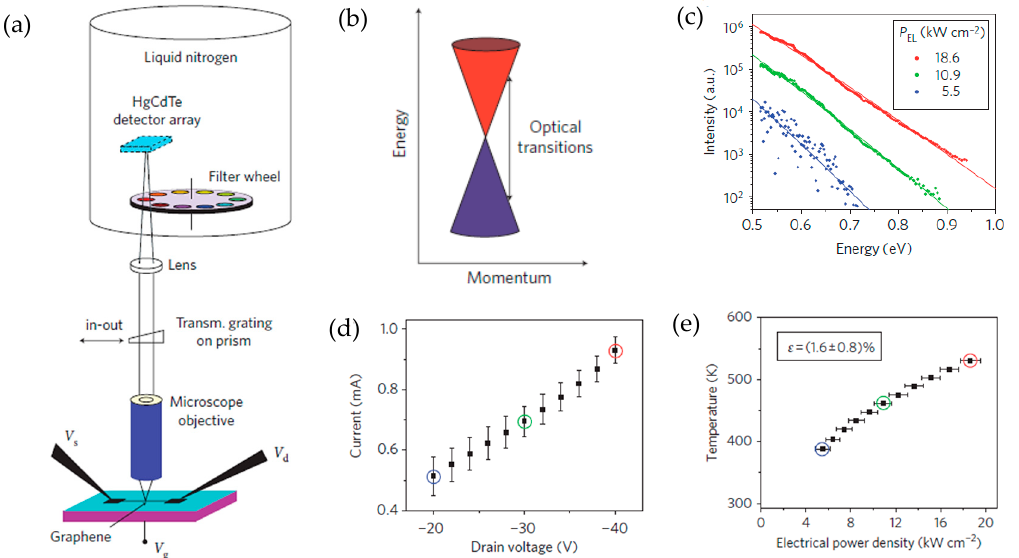
Figure 1. ( a ) Shows the experiment setup comprised of infrared imaging, vacuum prob station, and microscope with sensitivity between 0.95 and 0.5 eV. In this, the grating transmission was utilized for spectroscopy and then detached for infrared imaging; to cut down the dark count, a low pass filter was utilized. ( b ) The direct point vicinity related to the electron dispersion. ( c ) The measured intensity of thermal infrared radiation from biased graphene under three power levels, where the slide line agrees with grey body radiations, fit to Equation (1). ( d ) Shows I-V characteristics curve and the error bars were utilized because of slight hysteresis response observed in measurement, where, the values of red, green, and blue highlighted bars correspond to the electrical power level. ( e ) shows the temperature as a function of electrical power level, based on grey body fitting [50].